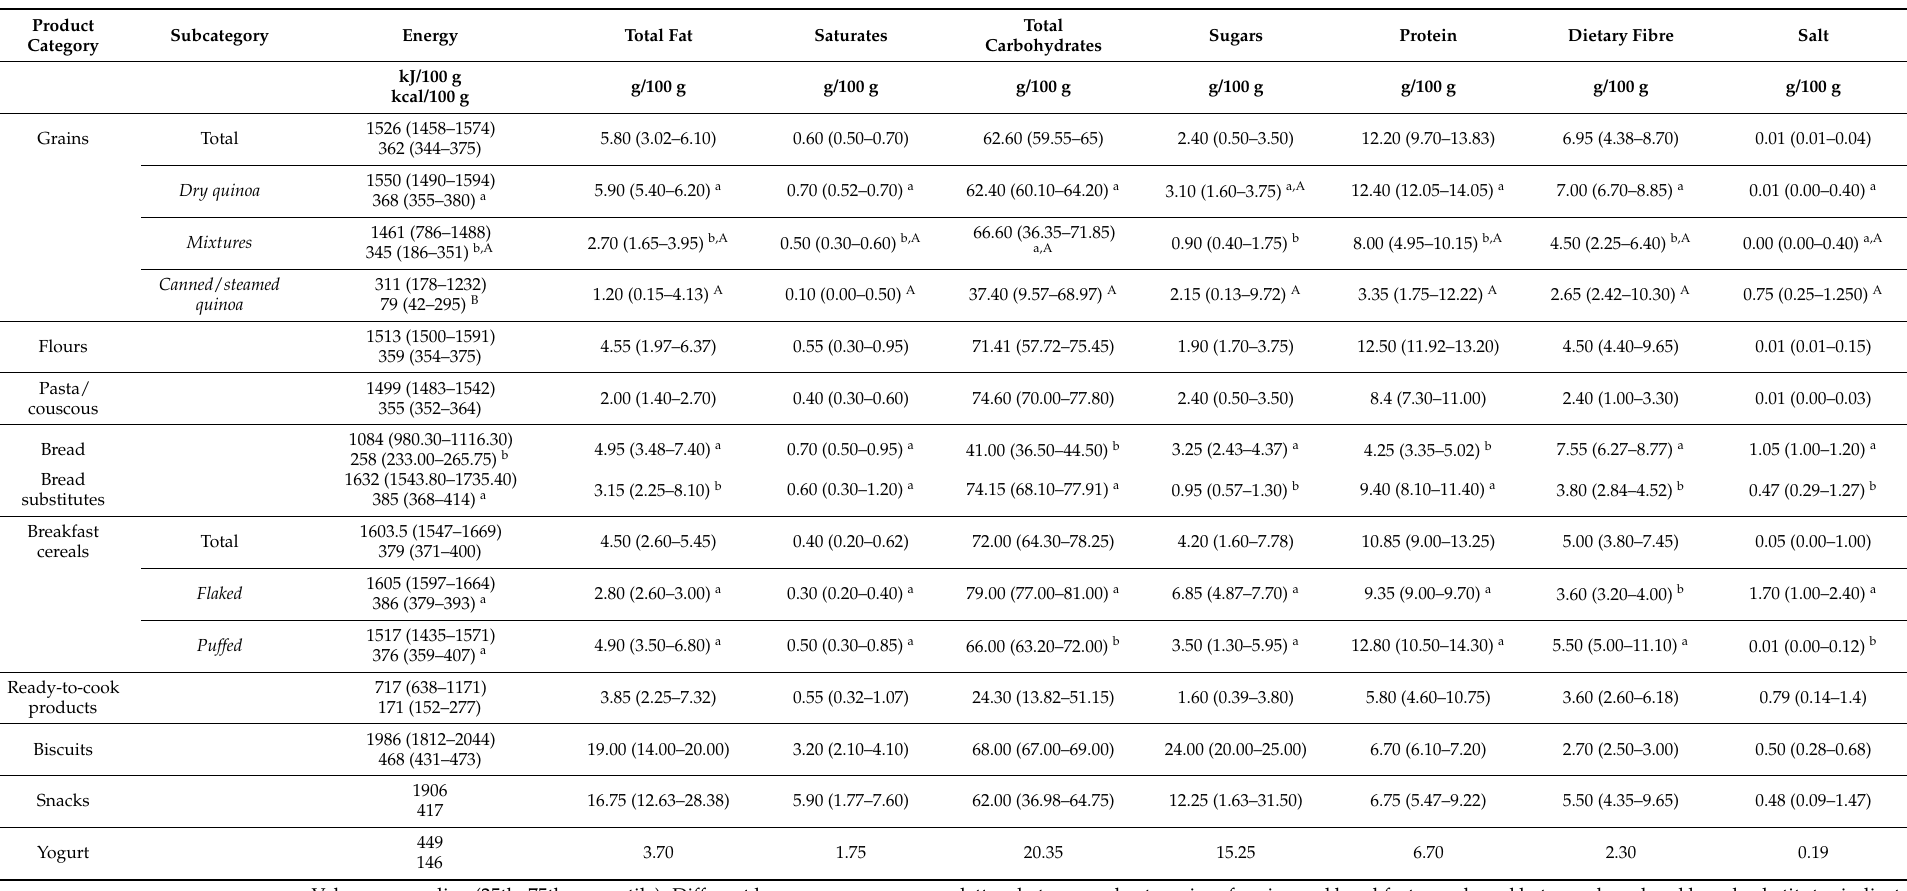
Table 2. Mandatory nutrition declaration across product